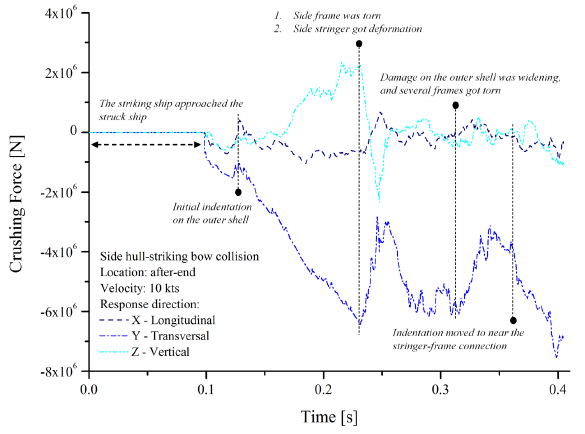
Figure 9: Force criterion and behaviour of the failure on the side hull: midsection impacted by velocity 10 kts.